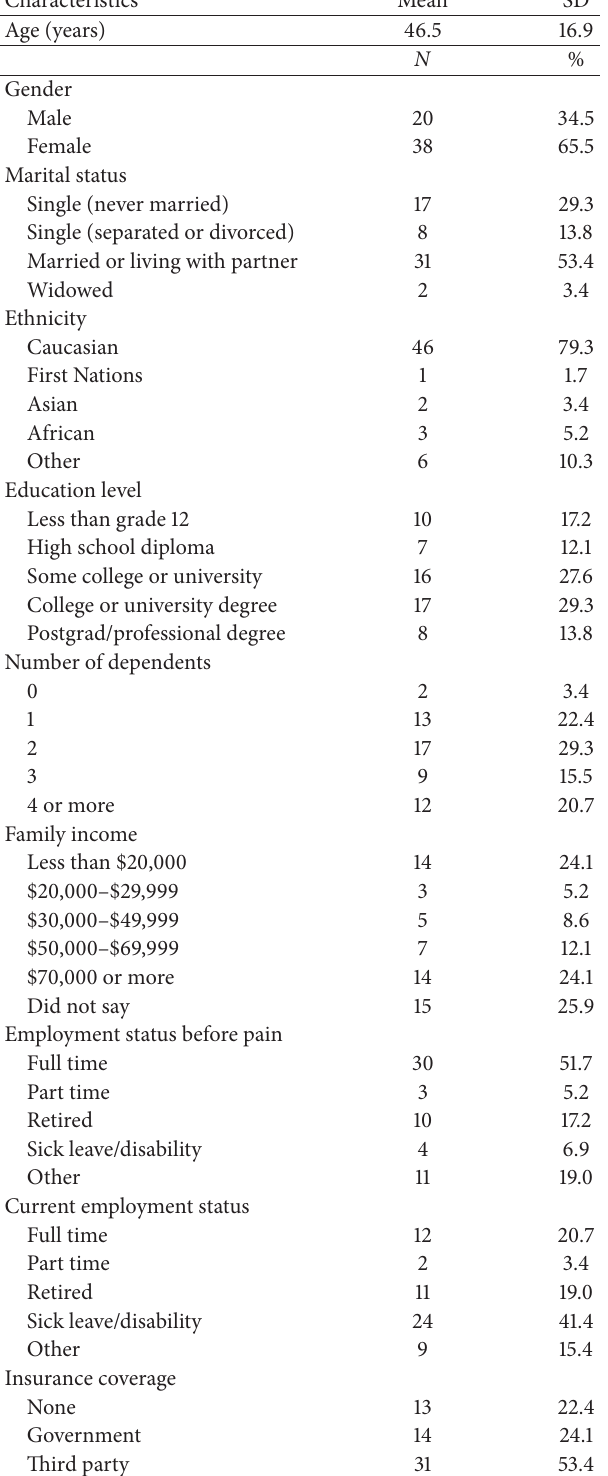
Table 1: Characteristics of 58 patients who visited the emergency department for chronic